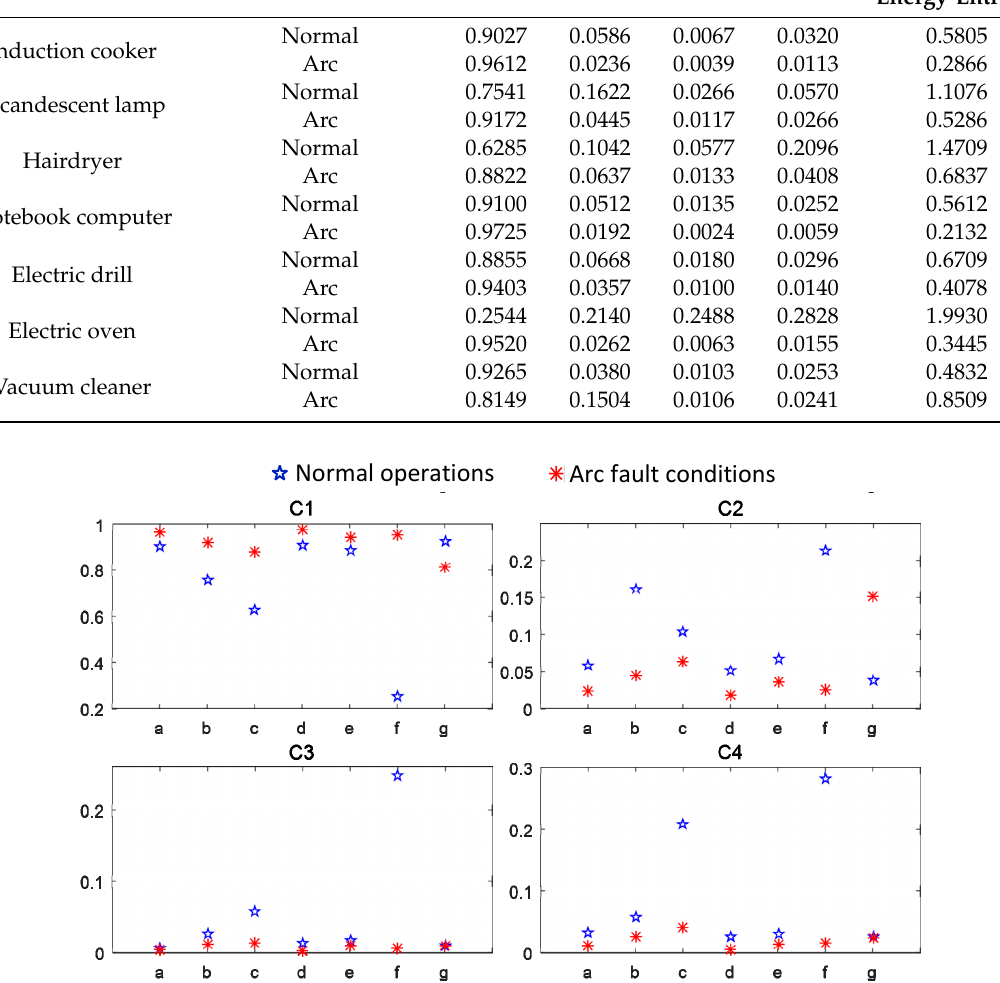
Figure 12. The wavelet packet energy-entropy of different load types during normal operations and serial arc fault conditions. (a) Induction cooker. (b) Incandescent lamp. (c) Hairdryer. (d) Notebook computer. (e) Electric drill. (f) Electric oven. (g) Vacuum cleaner.